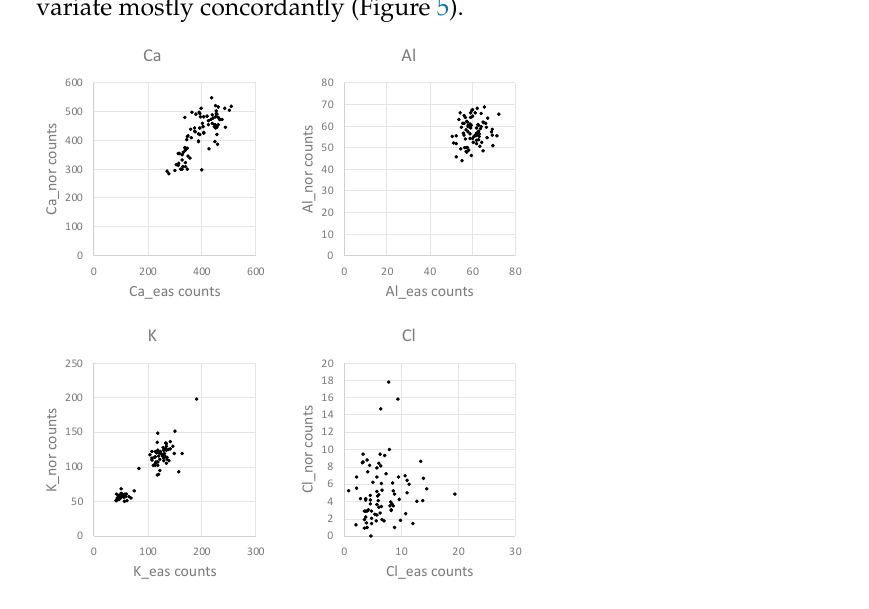
0.00100.00200.00300.00400.00500.00600.00